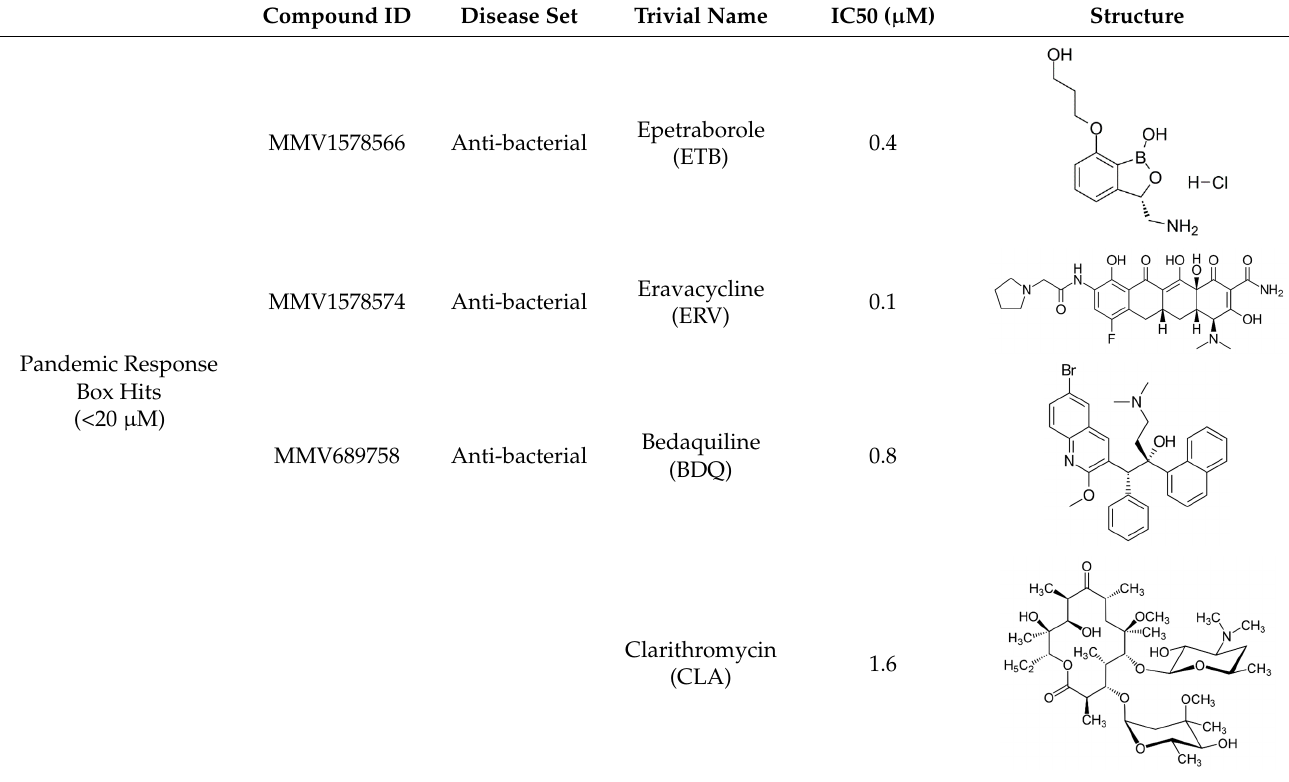
Table 1. Chemical structure and half maximal inhibitory concentration (IC 50 ) values of the 3 most potent Mab hits. Compound ID